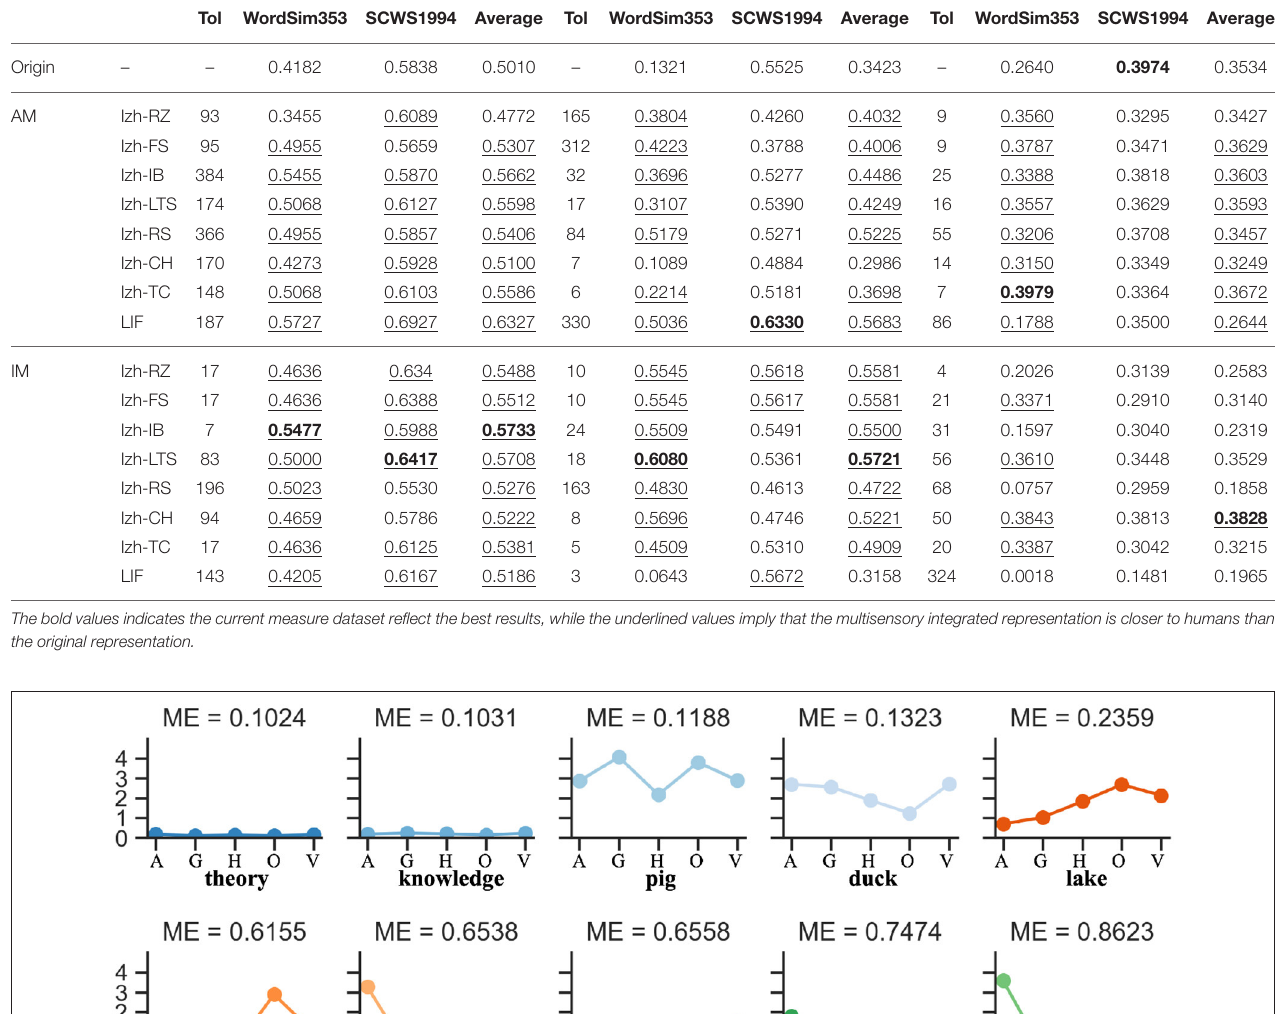
TABLE 2 | Concept similarity test results. Merge way Model